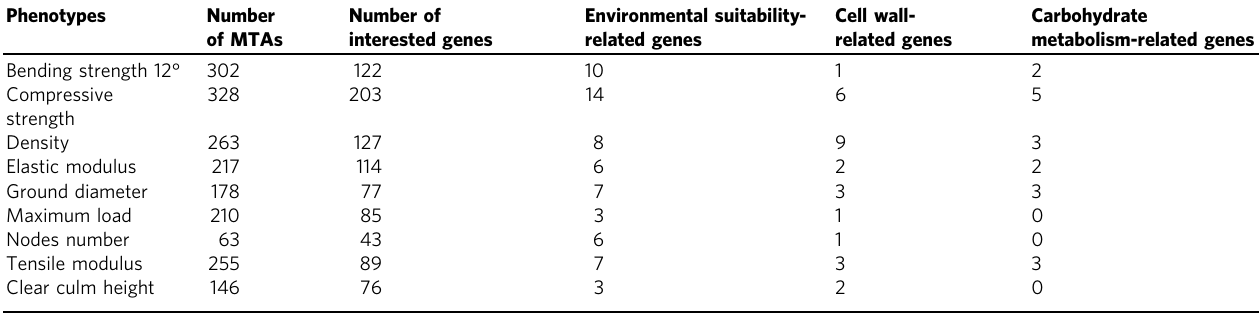
GWAS genome-wide association study, MTAs marker-trait